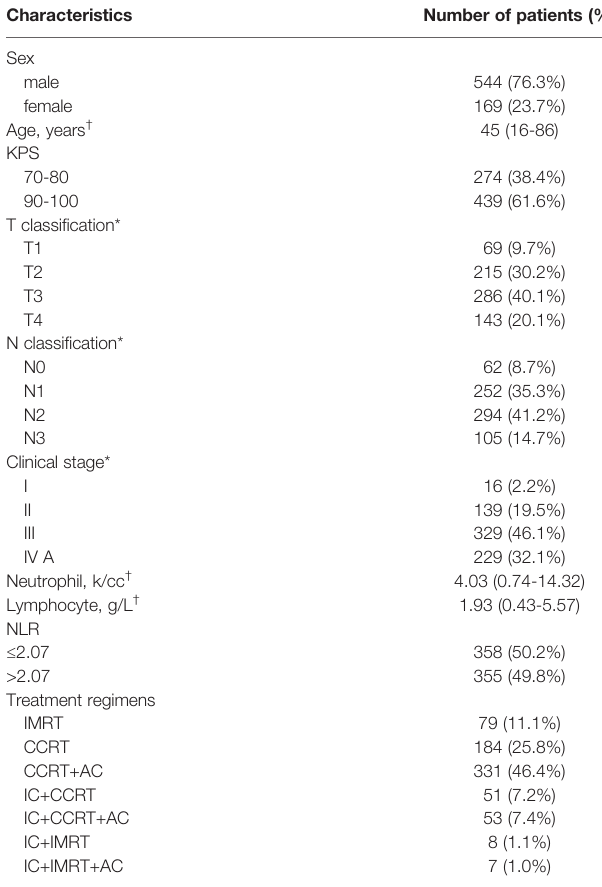
TABLE 1 | Characteristics of patients with nasopharyngeal carcinoma.